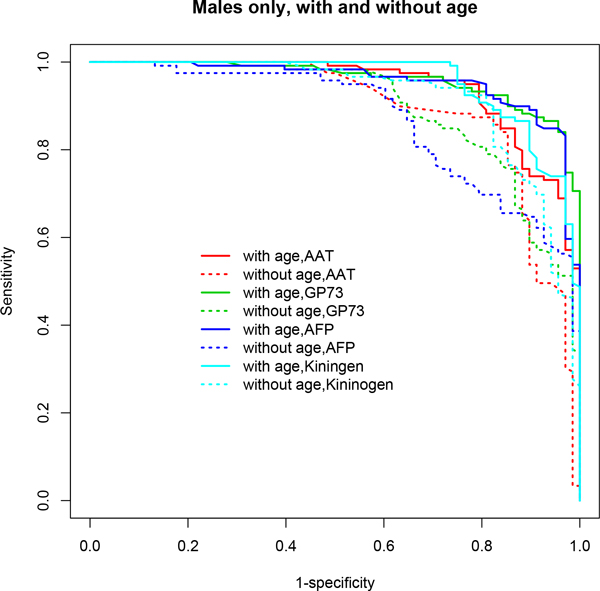
ROC curves based on multivariable model-based CART analyses (mob) using the stratified male-only subset. Age-adjusted models demonstrated superior performance in terms of AUC. A clear distinction is seen in the ROC curves for age-adjusted models (solid lines) compared to age-unadjusted models (dotted lines). See Table 1 for detailed results and the text for discussion of these results.